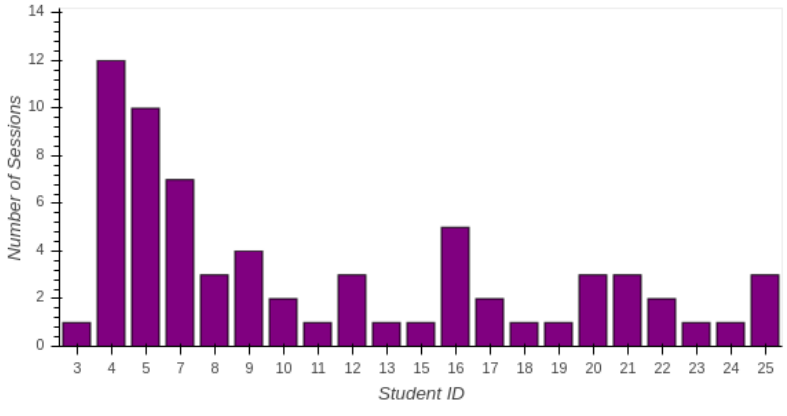
Figure 7. Amount of Sessions per